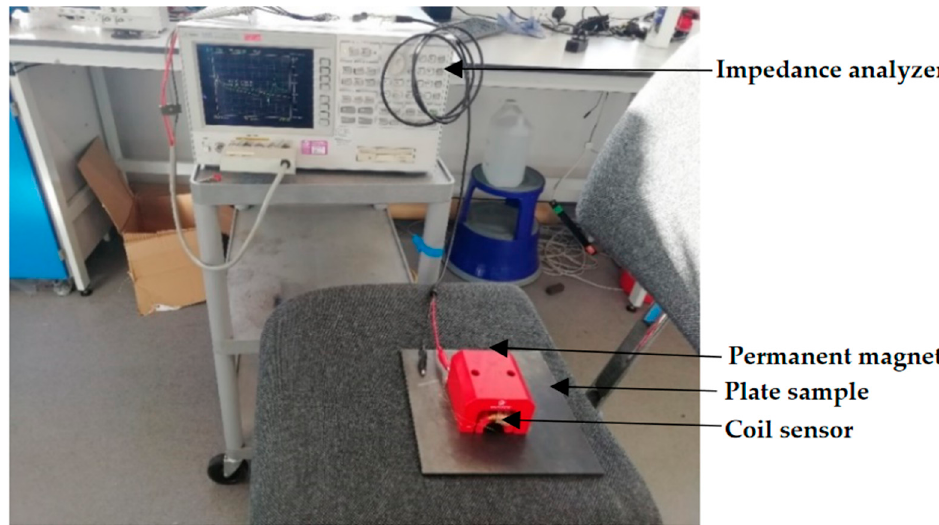
Figure 7. Coil sensor tested with impedance analyzer.